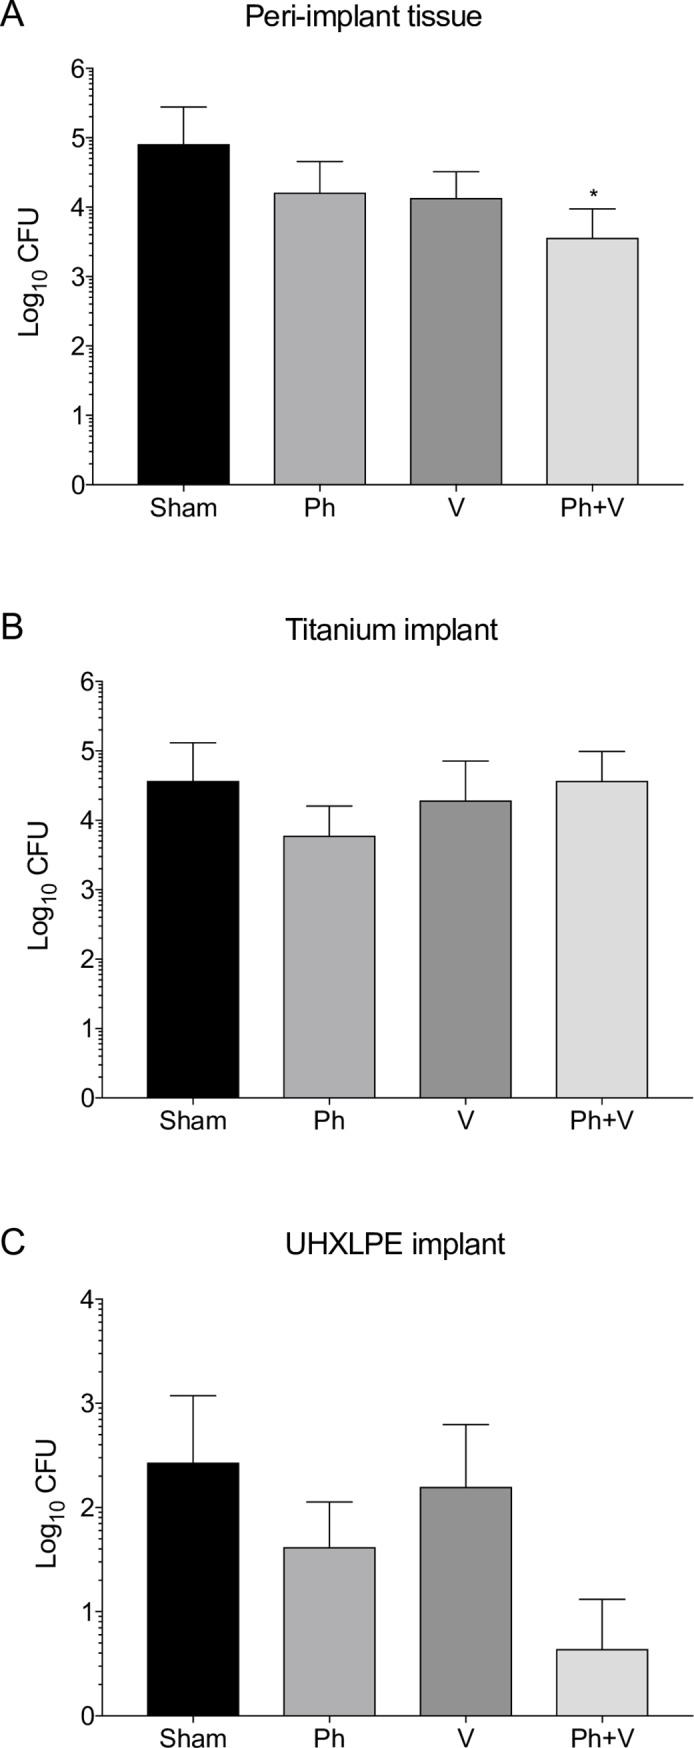
The effect of single and combination antimicrobial therapy on S. aureus numbers in implanted knees.Phage alone (Ph, n = 12), vancomycin (V, n = 11) or phage plus vancomycin (Ph+V, n = 12) was administered intraperitoneally to rats from day 21 post-surgery. Sham-treated (Sham) animals were administered an equivalent volume of sterile 0.9% saline. Peri-implant joint and bone tissue and implants were harvested from animals 7 days after commencement of antimicrobial therapy (28 days post-surgery) for enumeration of bacteria. The mean CFU count for the A) peri-implant tissue homogenates for the entire joint (a sum of the femur, tibia, patella and surrounding capsular tissue) following removal of implants, B) the titanium implants and C) the UHXLPE implants was determined for each treatment group. Data shows log10 CFU/tissue and log10 CFU/implant ± SD. *P < 0.05 compared to sham-treated animals.